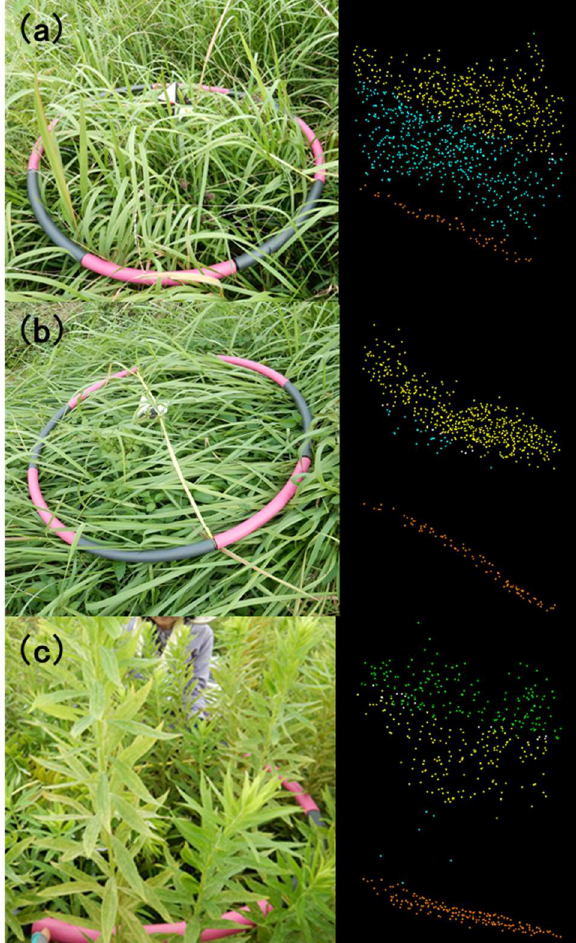
Figure 6. Reference photo (left) and profile of UAV LiDAR returns (right) in vegetation plots. UAV LiDAR returns in bottom vegetation layer (blue points) were properly recorded in (a) Imperata cylindrica (grass species) dominated plot, however, they were scarce in (b) falling Imperata cylindrica (grass species) and (c) Solidago altissima (forb species) dominated